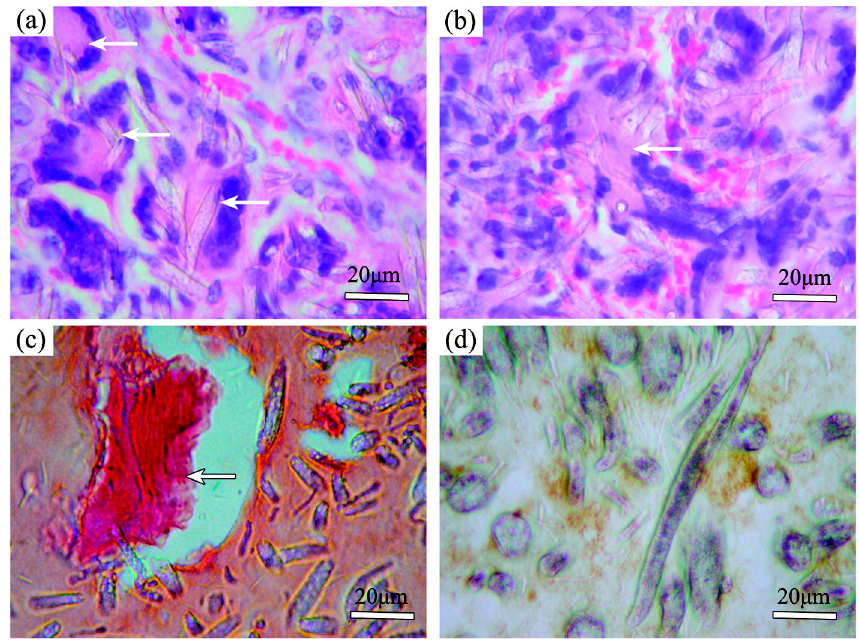
Figure 6. Histologic examination of cell/membrane composites implanted into immunodeficient mice: ( a – c ) show new-formed bonelike tissues in round or irregular shape (white arrow), and osteoblast-like cells were well arranged around bonelike tissues. Abundant blood vessels were found in the implanted area. In ( c ), alizarin red staining confirmed calcium deposits in new-formed bonelike tissues. In ( d ), osteocalcin, which was stained in brown, was detected in the cytoplasms and outside the cells. Reprinted with permission from [143]. Copyright (2007) American Chemical Society.